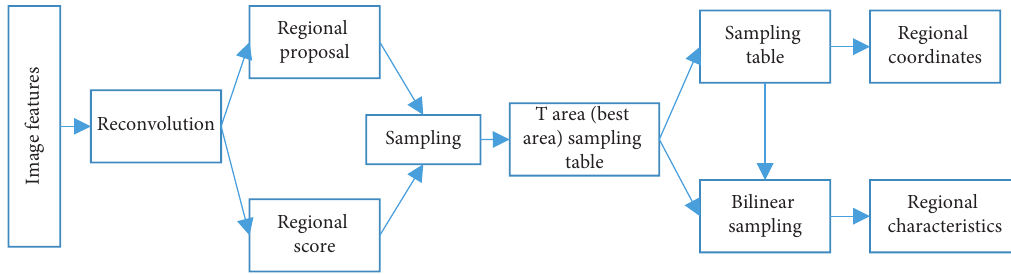
Figure 3: Faster R-CNN-based target detection model.